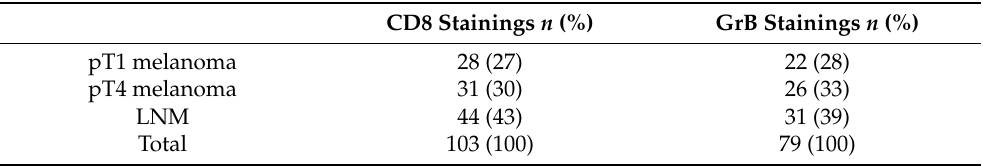
Table 2. Sample sizes of analyzed CD8 and GrB stainings including clinicopathological data. pT = pathological tumor stage, LNM = lymph node